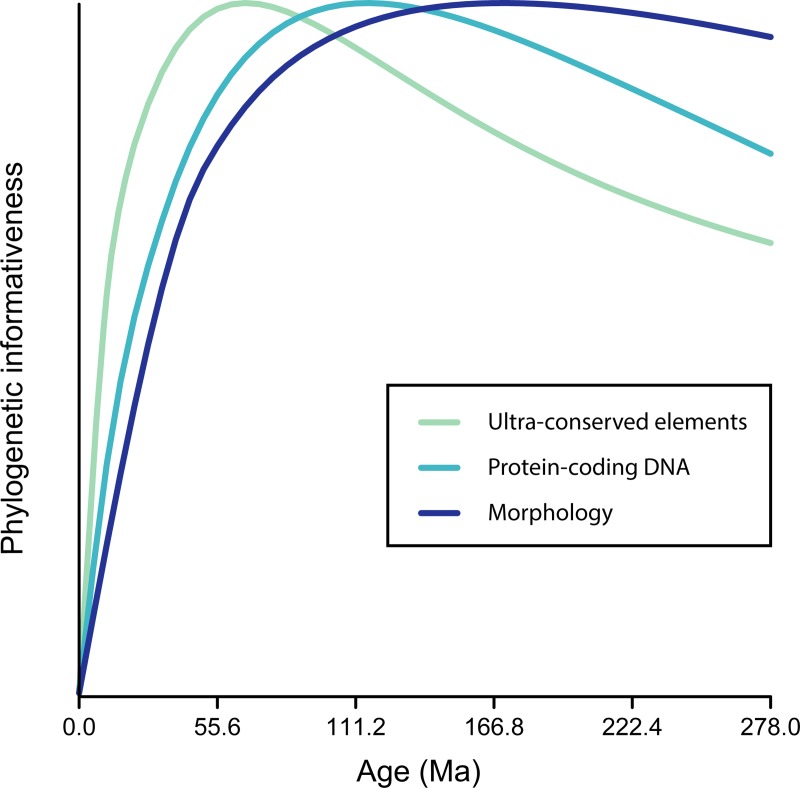
Comparison of the PI profiles for the protein-coding (same as in Fig 3) and UCE datasets with morphology.Morphology evolves at a slower rate, leading to a PI-profile peak at around 171.5 Ma, an age markedly older than either molecular dataset. The rate of decay is also less steep for the morphological data. Thus, morphology accumulates noise at a much slower pace, potentially retaining more phylogenetic signal to resolve ancient and short branches. The height of the profiles is standardized to emphasize their temporal dynamics; when calculated without standardization, peak informativeness is 75% lower for morphology, and 55% lower for UCEs, than is the peak for protein-coding data measured on a per character basis. This standardization is applied in recognition of the fact that morphological characters are preselected to be informative during the timeframe under study; therefore, their absolute informativeness cannot be compared directly, whereas the shape of their informativeness profile—when their rate of change implies that they will be useful for phylogenetic inference—remains of interest.